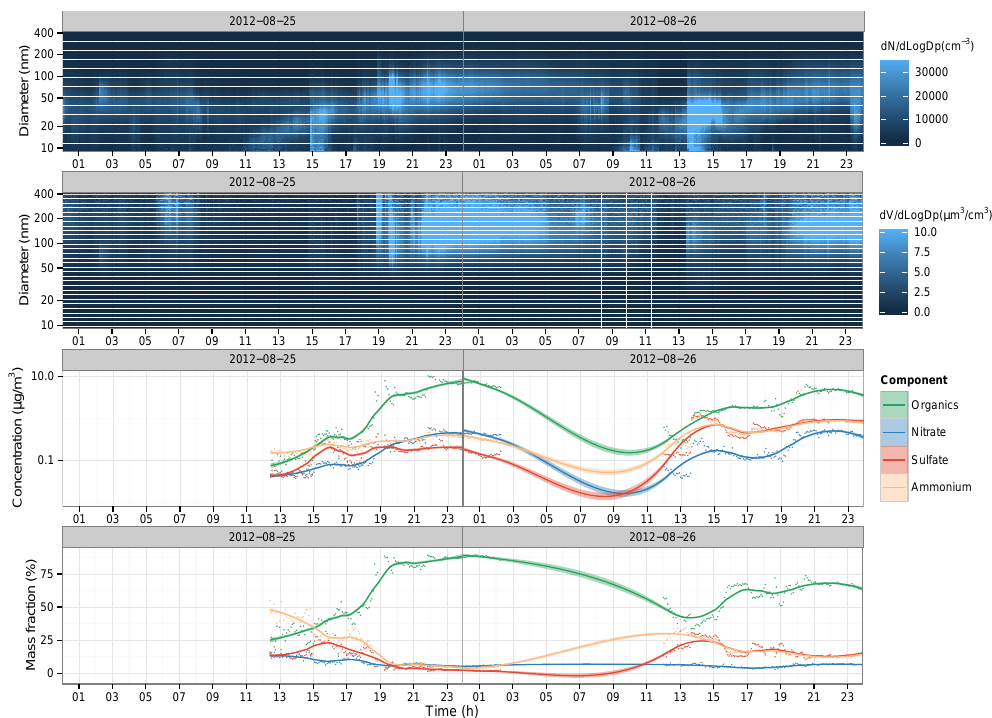
Figure 4. Time series of the particle number/volume size distributions (top two graphs) and mass concentration of particle species and their fraction to the total (bottom two graphs) at s25. Solid lines are calculated using LOESS smoothing technique, and the shaded areas represent the 95% confidence